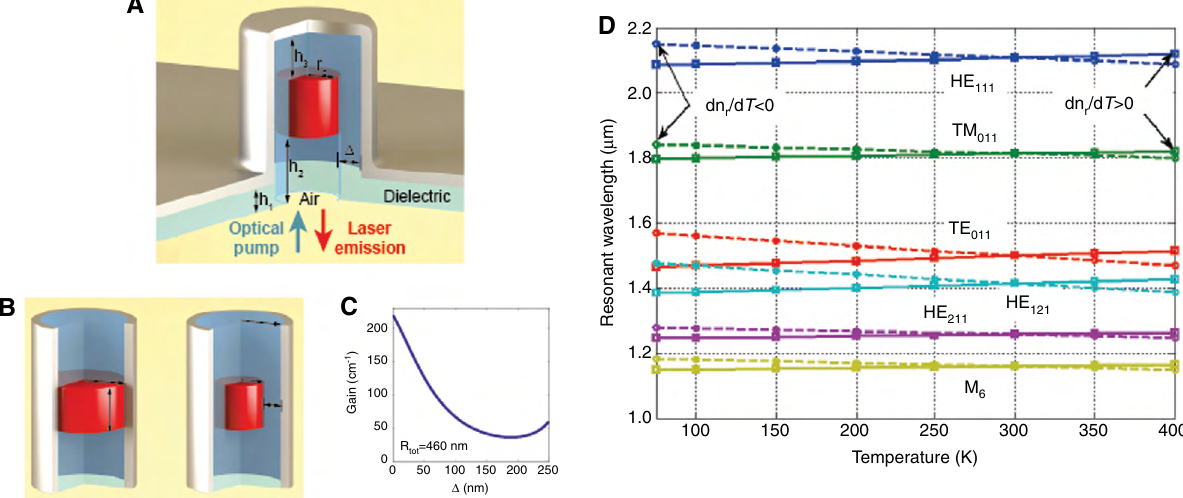
Figure 3 (A) 3D optically pumped metallo-dielectric nanolaser schematic. The air gap at the bottom of the laser is formed after selective etch of the InP substrate In the designed cavity the values for h , h , and h are 200 nm, 550 nm and 250 nm, respectively. (B, left) Metal- 1 2 3 coated gain disk with vertical confinement provided by low index waveguide cutoff sections. (A, right) The structure shown in (B, left) but now including a dielectric shield layer with thickness Δ . (C) Variation of gain threshold of the composite the dielectric shield thickness = 460 nm. (D) Cavity resonances as a function of temperature for a cavity similar to that of Δ is changed, assuming a fixed total radius R tot = 350 nm and the optimal SiO (A) except R shield layer is 100 nm. Hence the lower order modes cover the near-infrared wavelengths. tot 2 (Reprinted from [20] and [35]).